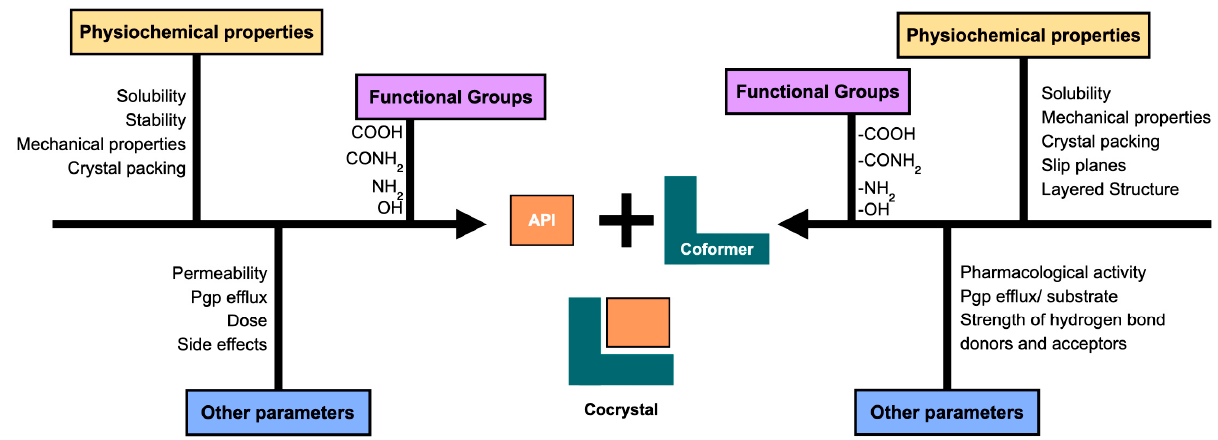
Figure 3. Properties of coformer and drug to be considered while designing the cocrystal.